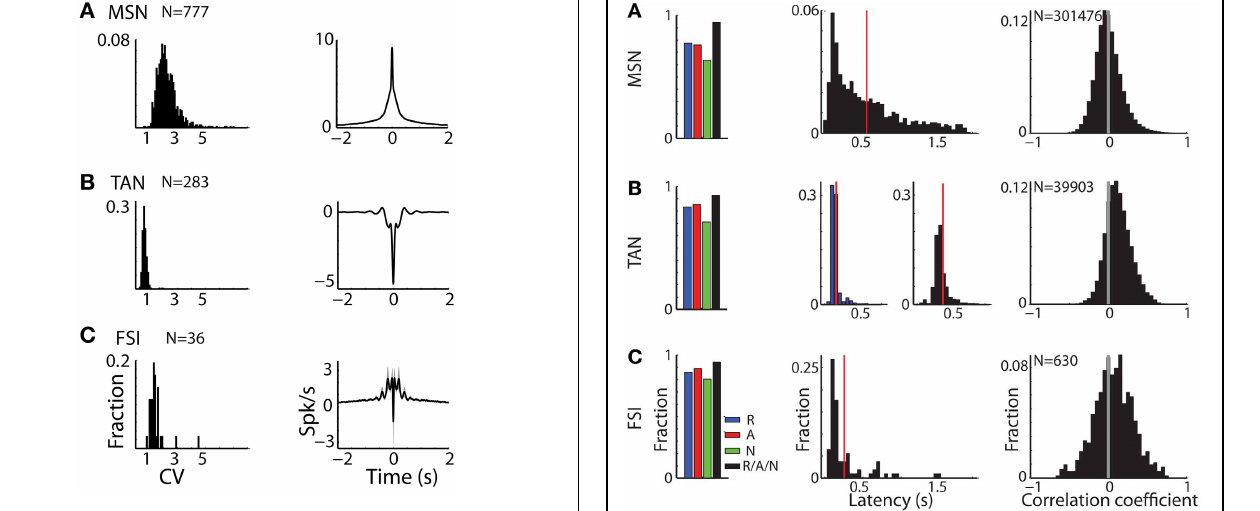
FIGURE 4 | Different response characteristics of striatal MSNs, TANs, and FSIs. (A) MSN response profile. Left subplot: distribution of MSNs that had a significant response. Blue, red, and green bars: fraction of cells that had a significant response for reward, aversive, and neutral events, respectively. Black bar: fraction of cells that had a significant response to at least one of the task events. Second subplot: distribution of response onset. Abscissa: time in seconds for significant increase in firing rate. Red line marks the average response onset time. Right subplot: distribution of the signal correlation between all (simultaneously and non-simultaneously recorded) MSN pairs. N is for number of pairs. (B) TAN response profile. Same conventions as in (A) . In the second subplot: distribution of response onset, left and right columns: latency of significant decrease and increase in firing rate, respectively. (C) FSI response profile. Same conventions as in (A)